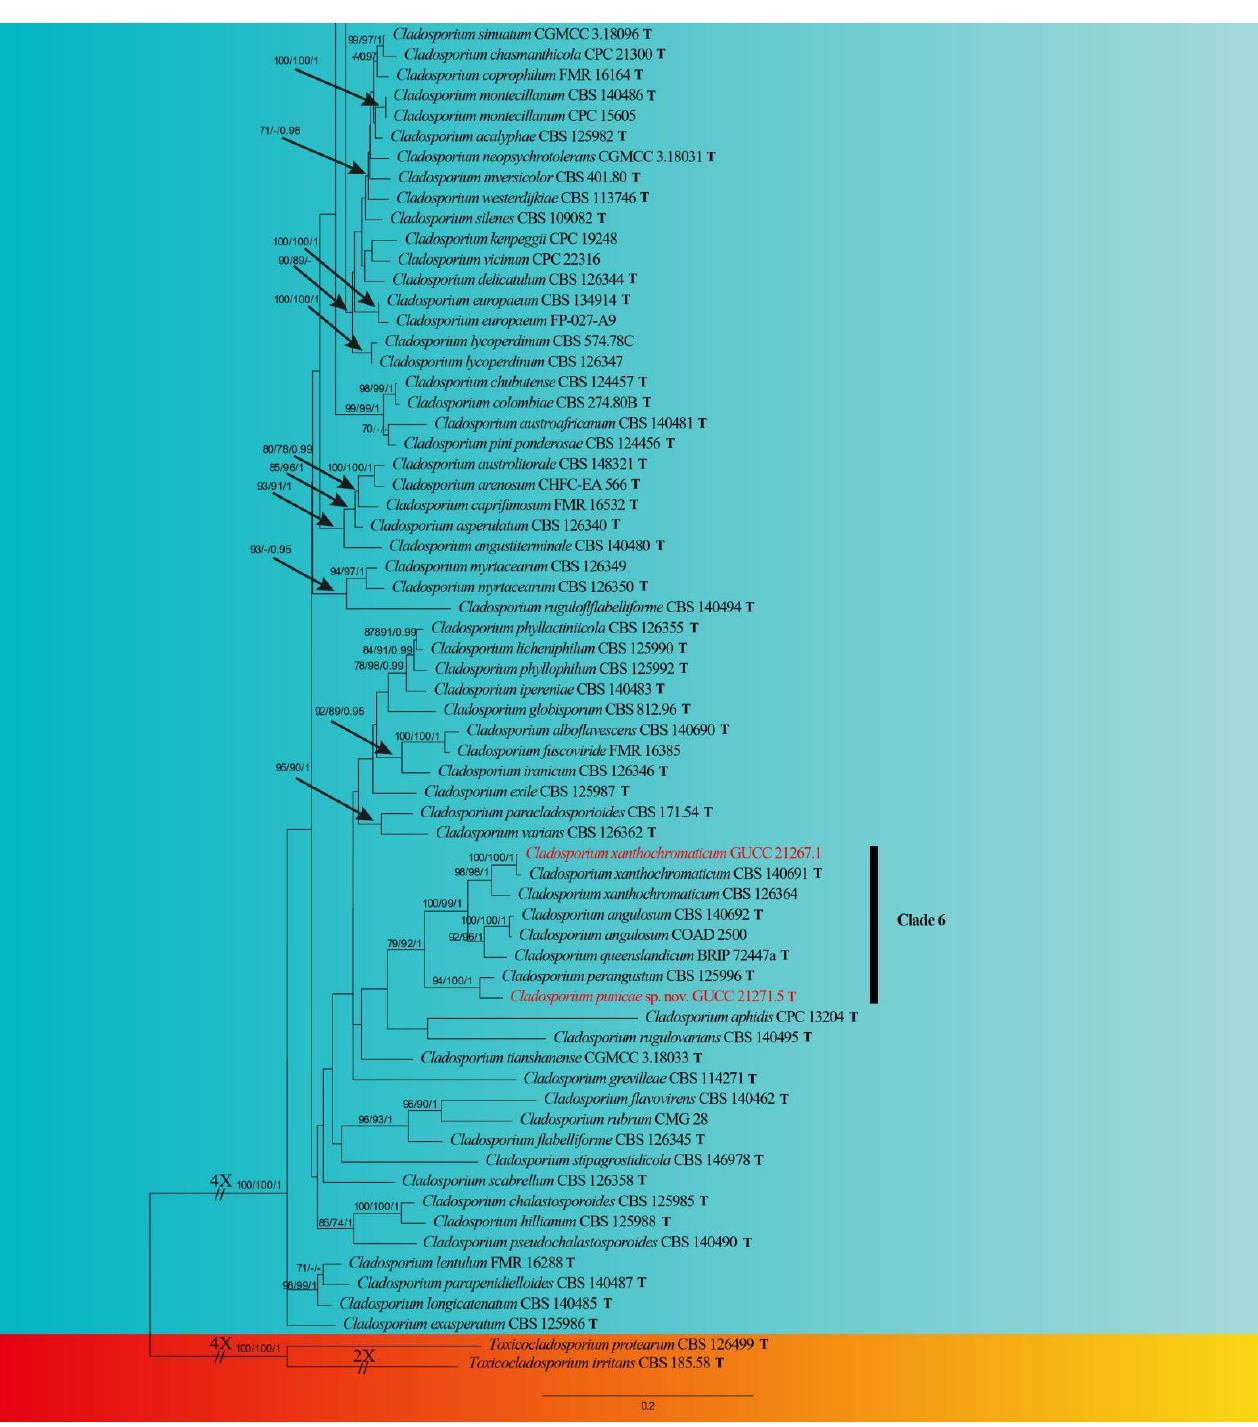
Figure 1. Maximum likelihood (RAxML) tree from the combined analysis of ITS, tef 1- ɑ and act sequences of Cladosporium taxa. The tree was rooted with Toxicocladosporium irritans (CBS 185.58) and T. protearum (CBS 126499). ML and MP bootstrap values (above 70%) and Bayesian posterior probability (above 0.95) are indicated along branches (ML/MP/PP). Our isolates are highlighted in red. T = ex-type strain.